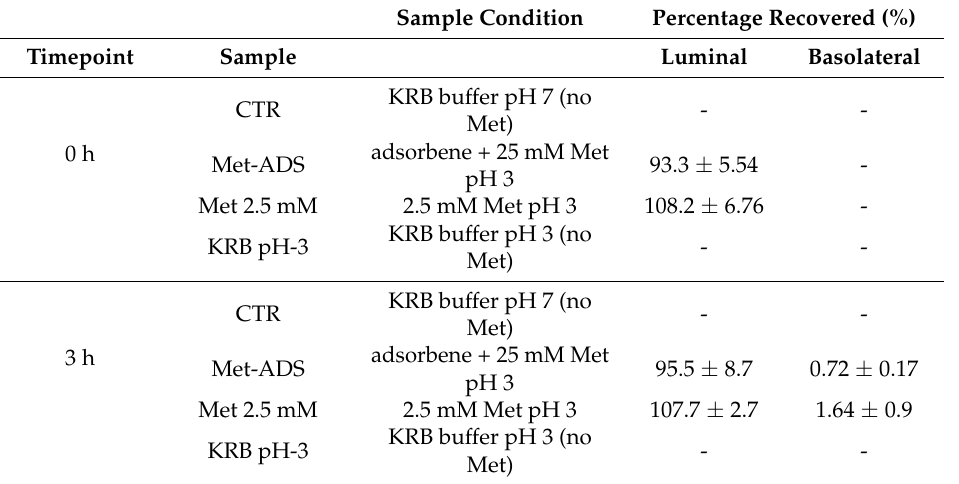
Table 3. Methionine percentage investigated in the Ussing chamber with porcine mucosa. Results are presented as a percentage of the luminally applied dose recovered (%) at the beginning of the experiment (0 h) and after 3 h of incubation. Sample Condition Percentage Recovered